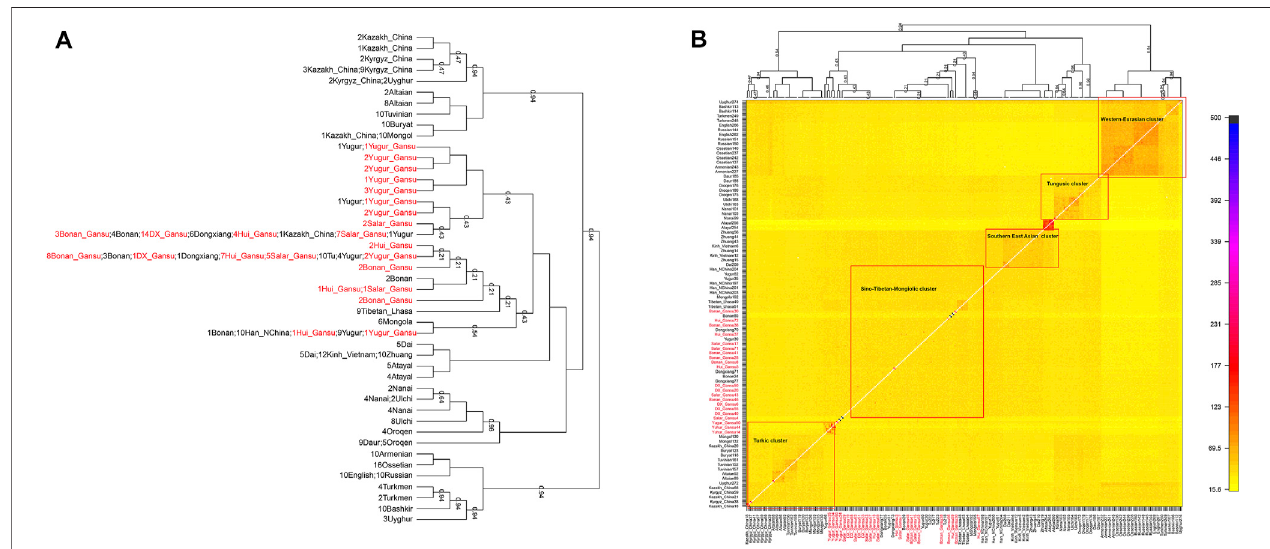
FIGURE 6 | The heat map of sharing haplotypes and clustering dendrogram by fi neSTRUCTURE. DX (cid:1) Dongxiang. (A) the dendrogram. (B) the heat map of sharing haplotypes.